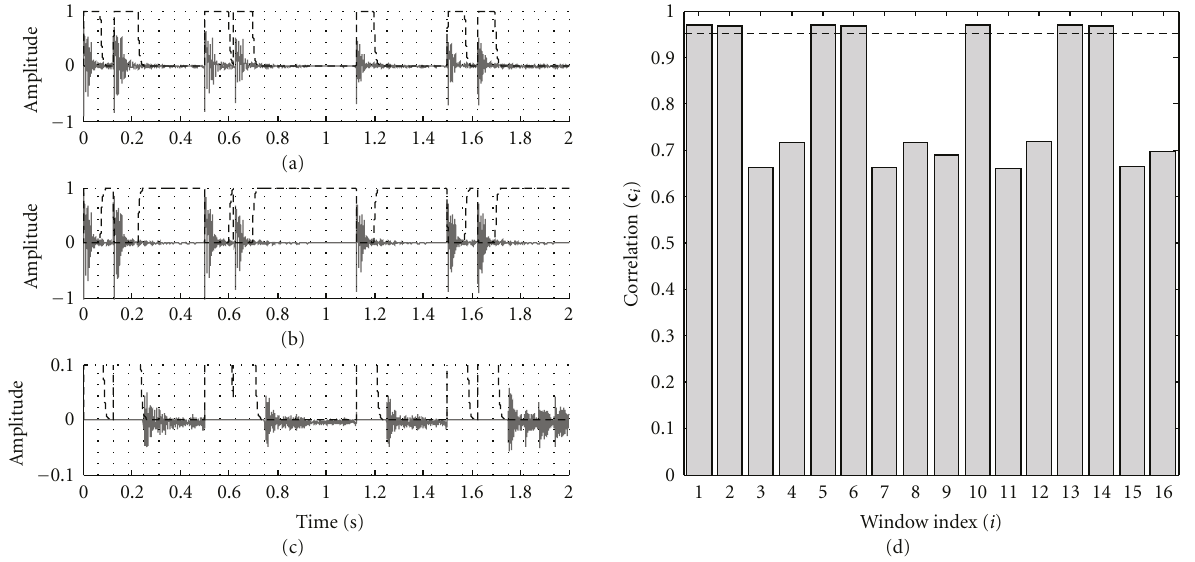
Figure 2: Approximations to the kick drum and bleed signals, (a) contains the noisy signal y n , (b) contains the synthesized clean kick drum signal y z , (c) contains the component of the signal attributed to bleed y b , and (d) shows the correlation of the spectral power of each window with the spectral power of the clean kick drum signal. The correlation threshold is identified by the dotted